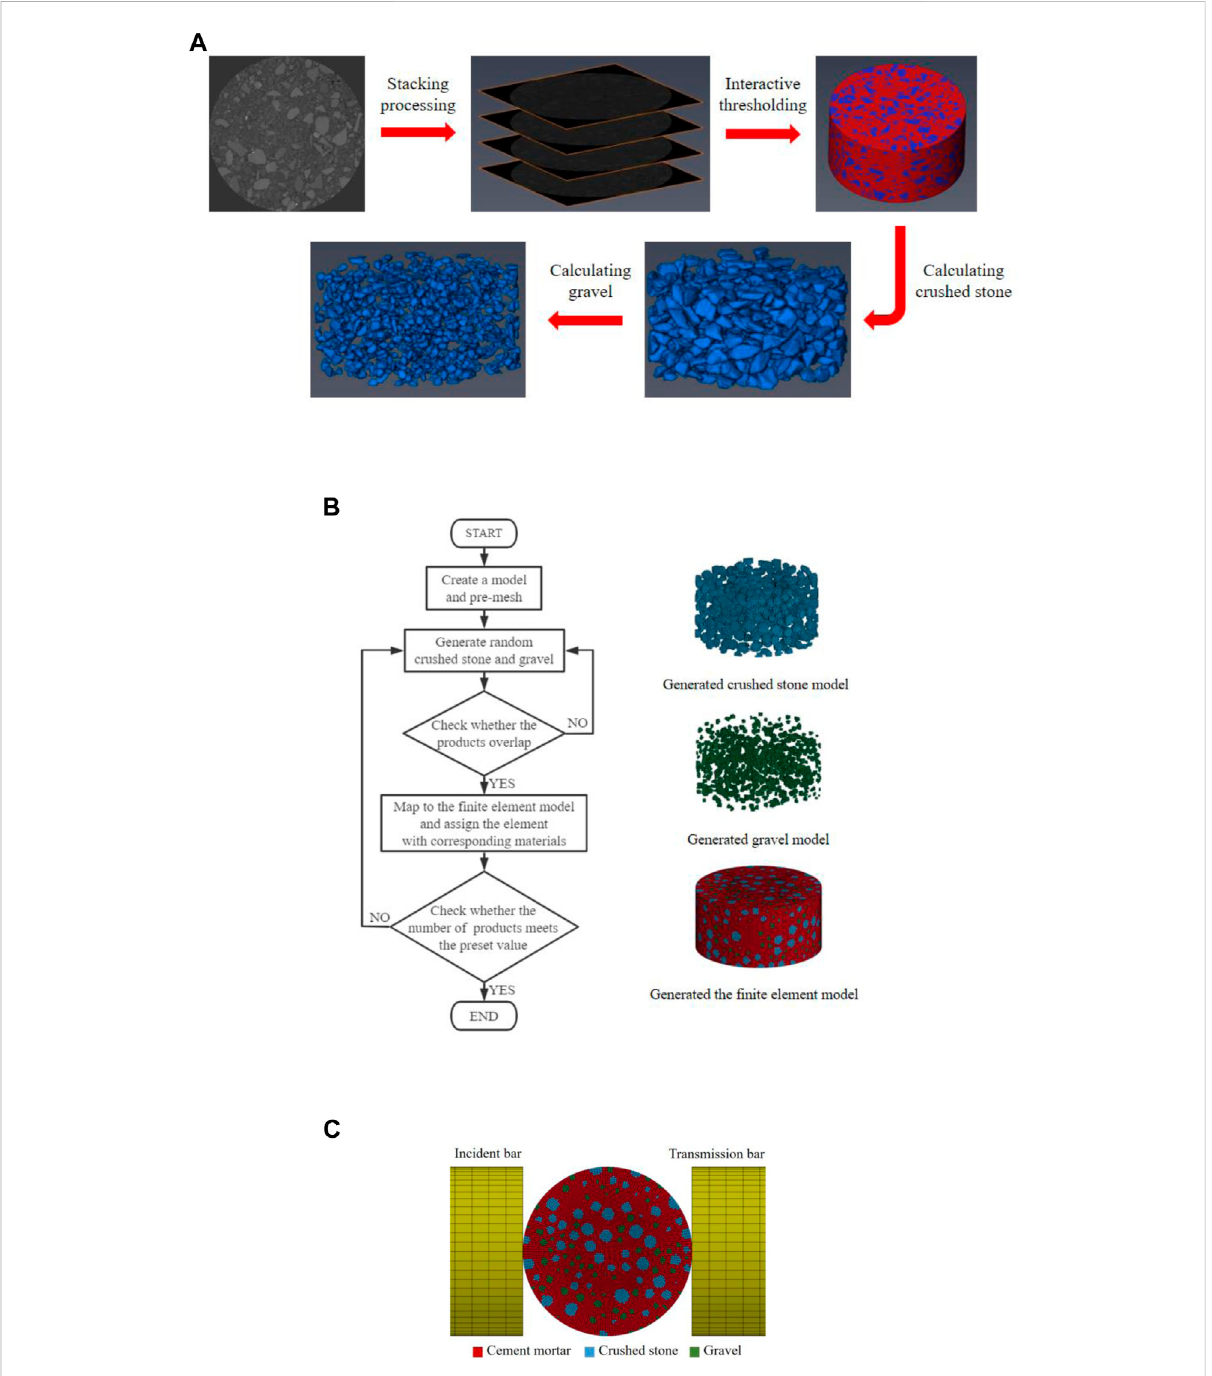
FIGURE 3 The meso-scal FEM model of grouting specimen. (A) AVZIO processing, (B) Flow chart of generating mesoscale fi nite element model of the grouting specimen, (C) Simpli fi ed model of the SHPB simulation